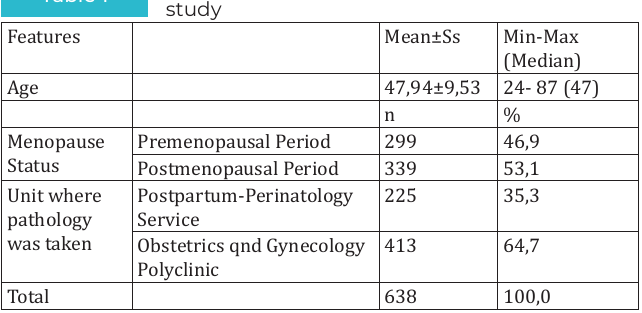
Characteristics of the data included in the study